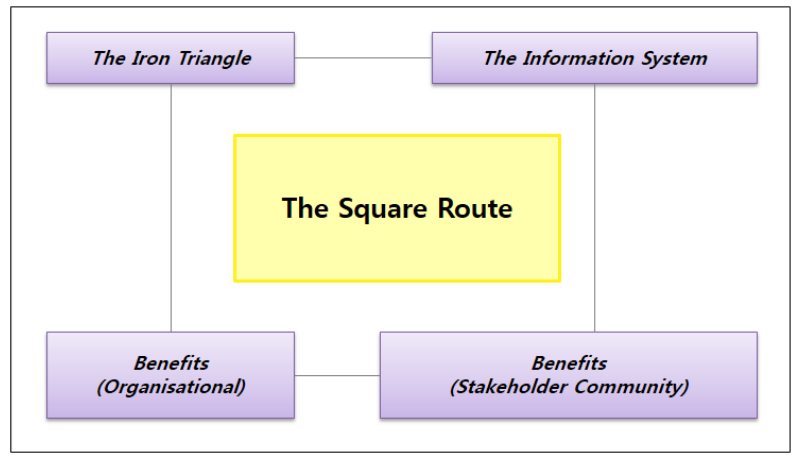
Figure 3. The Square Route of Atkinson.